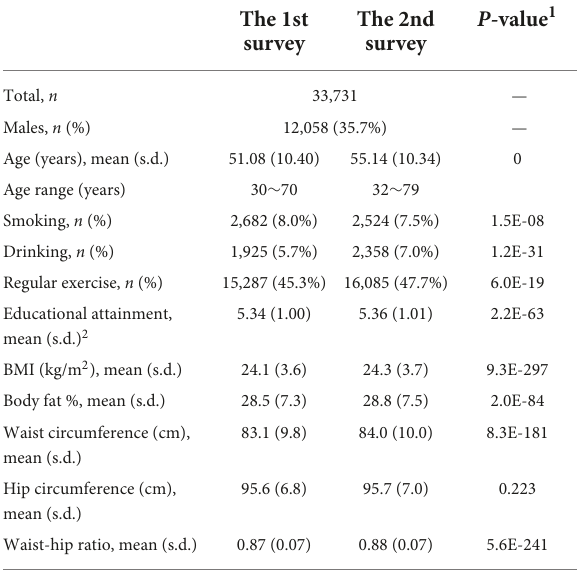
TABLE 1 Basic characteristics of the 33,731 Taiwan biobank